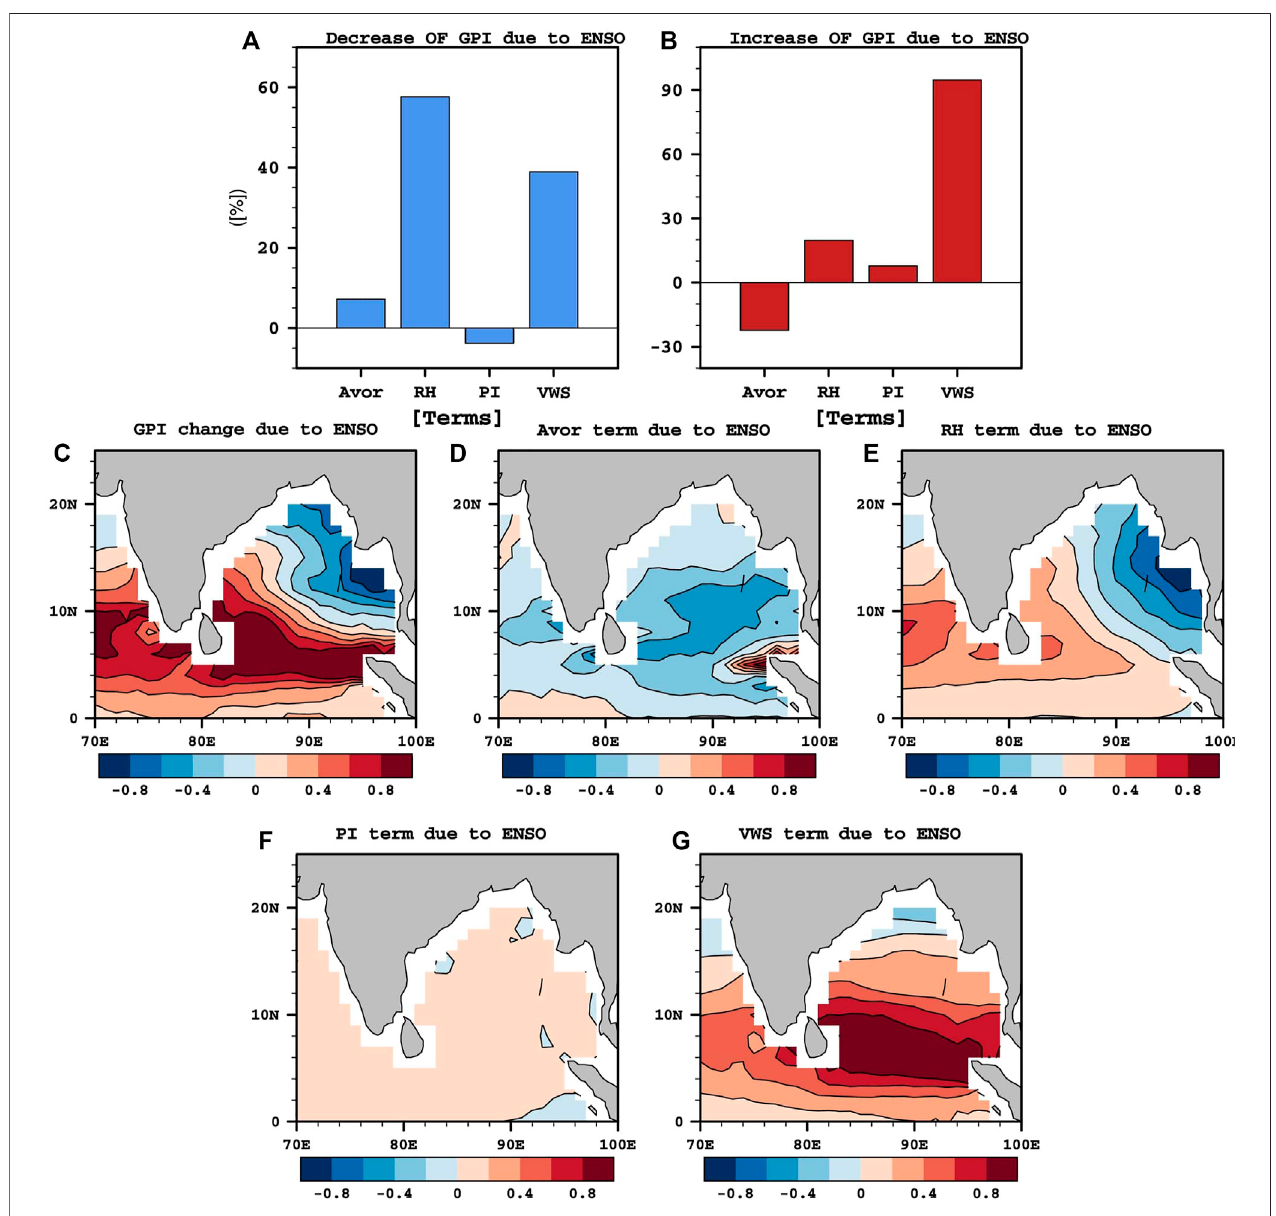
FIGURE 5 | (A) Relative contributions (percentages) of each term to the diagnosed GPI changes associated with ENSO (Niño-3.4) during OND over the northeastern boxed region(15 ° – 22 ° N,85 ° – 95 ° E)and (B) thesouthwesternboxed(red)regionin Panel4 . (C) ThediagnosedGPIchangeintheBoBduetoENSOandthespatialdistributionofdiagnosed four large-scale terms; (D) absolute vorticity at 850 hPa (Avor), (E) relative humidity at 700 hPa (RH), (F) potential intensity (PI)and (G) vertical wind shear